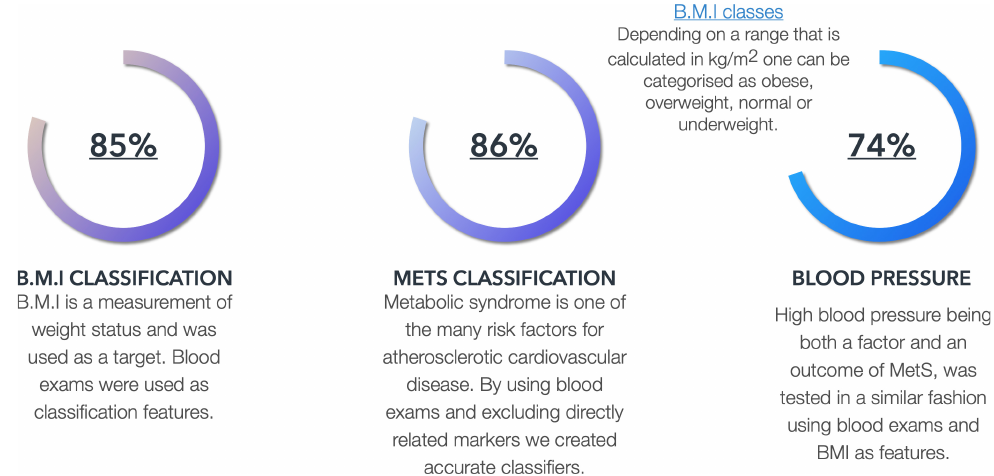
Figure 1. Developed methodologies and